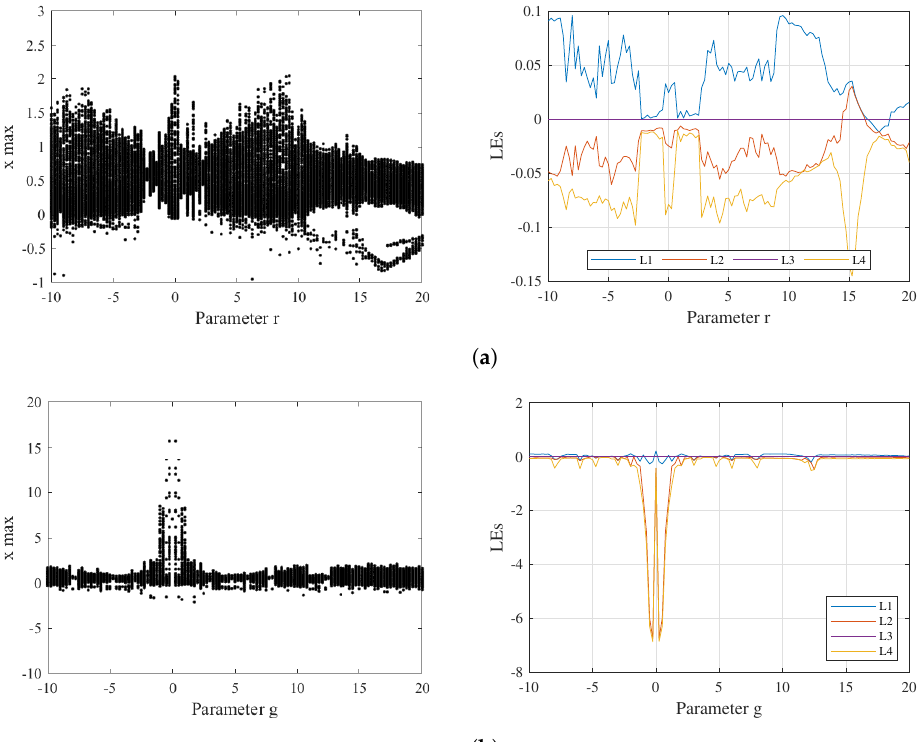
Figure 9. Dynamics of fractional-order hyperchaotic system (4) showing the bifurcation diagram ( left ) and Lyapunov exponent spectrum ( right ), when ( a ) g = 5 and r varies; ( b ) r = 15 and g